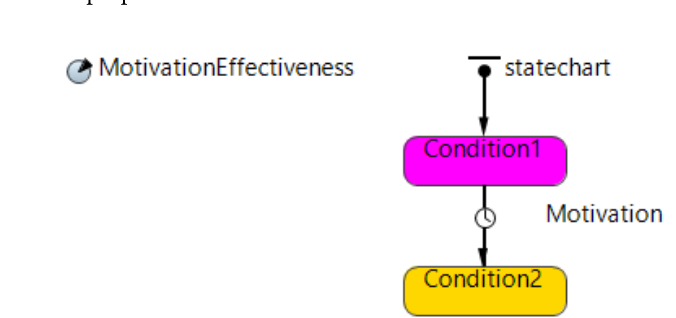
Figure 6: Adjust state properties.